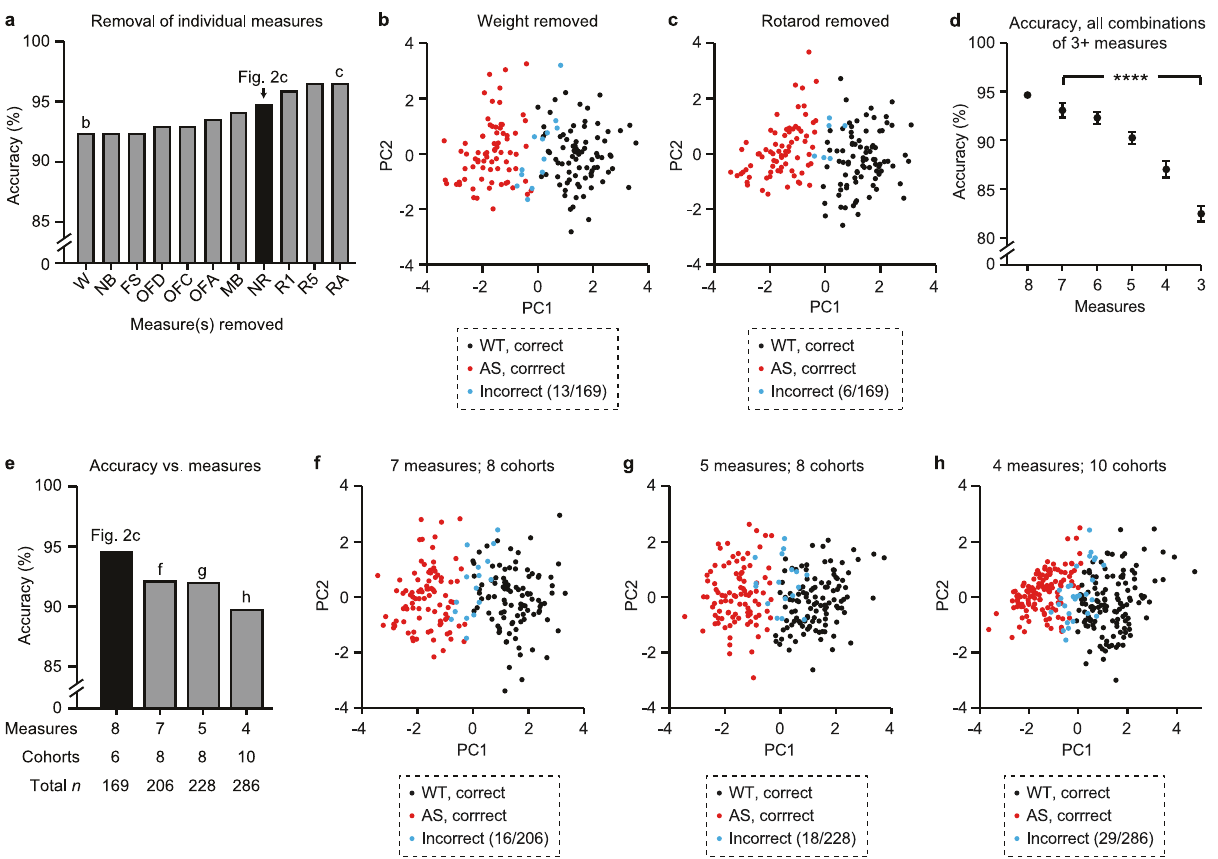
Fig. 3 Multidimensional analysis remains effective with different combinations of behavioral data. a Removal of individual measures and individual behavioral tests resulted in clustering accuracies ranging from 92 – 97%. Each bar represents a condition where one measure or test was excluded; black bar represents the full dataset ( n = 169) with nothing excluded. b The lowest accuracy achieved was 92.9% with weight excluded from analysis. c The highest accuracy achieved with removal of a single test was 96.5% with rotarod excluded. d Average accuracy across all combinations of measures used ranged from 82.5% (3 measures) to 93.1% (7 measures). Data represent mean ± SEM; **** p < 0.0001, one-way ANOVA. 8 measures: n = 1, 7 measures: n = 8, 6 measures: n = 28, 5 measures: n = 56, 4 measures: n = 70, 3 measures: n = 56. e Multidimensional analysis in larger sample sizes was achieved by including fewer behavioral tests. f – h Accuracy of different conditions shown in e ranges from 89.9% to 92.2%.